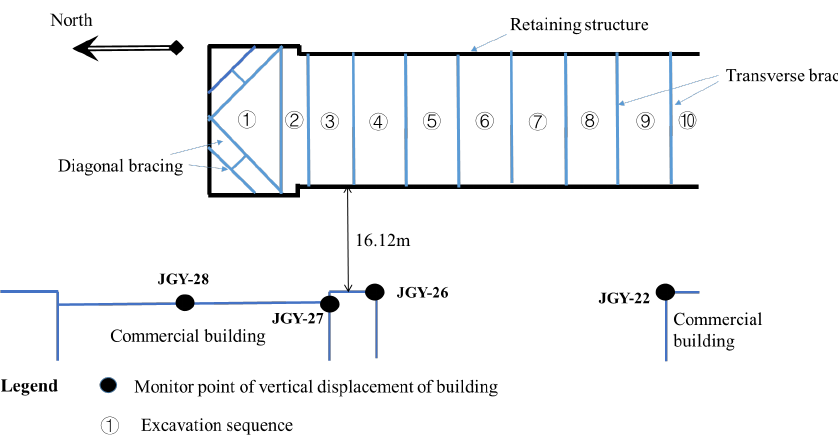
Figure 7. Position of the buildings and the excavation.